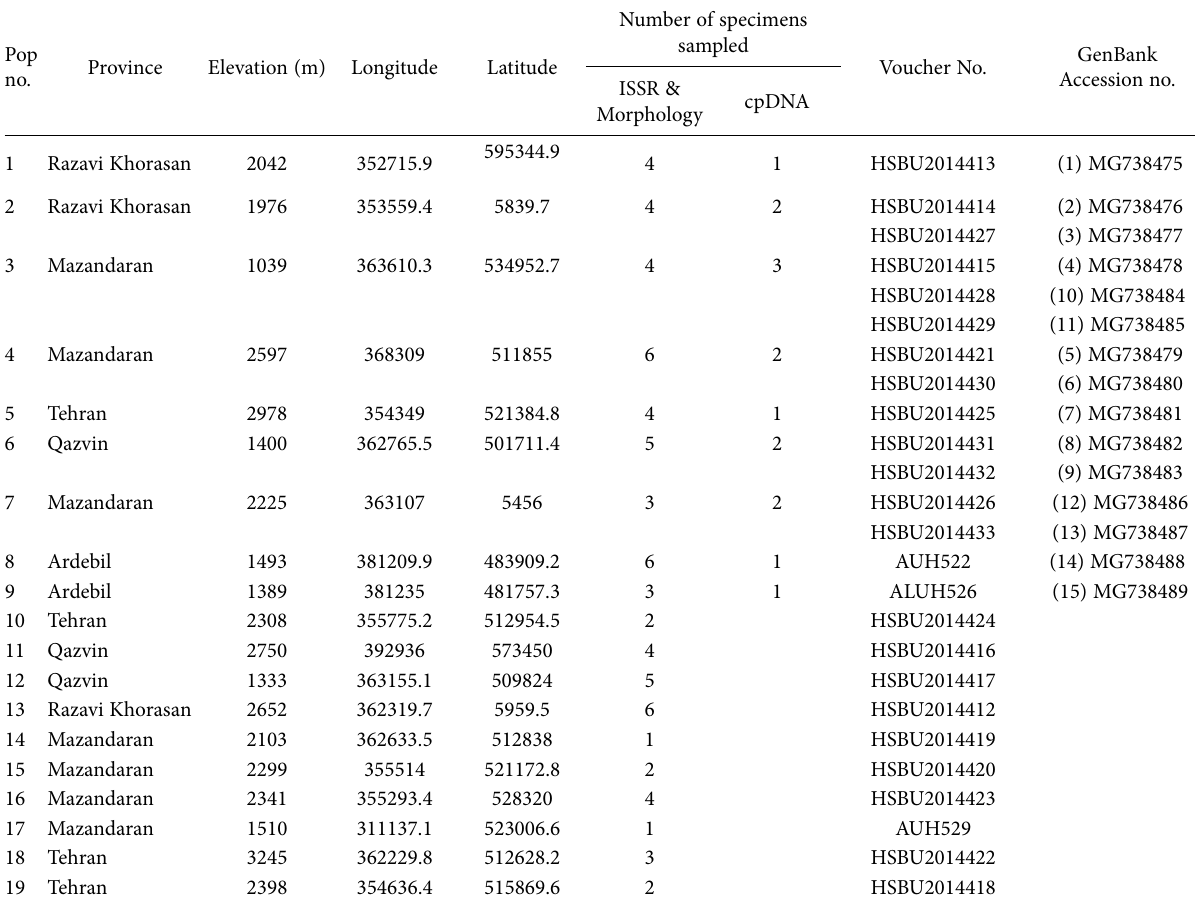
Table 1. Locality information for populations of Z. clinopodioides sampled, including herbarium vouchers for specimens used for morpho- logical and ISSR analyses and GenBank Accession numbers for specimens used for cp-DNA